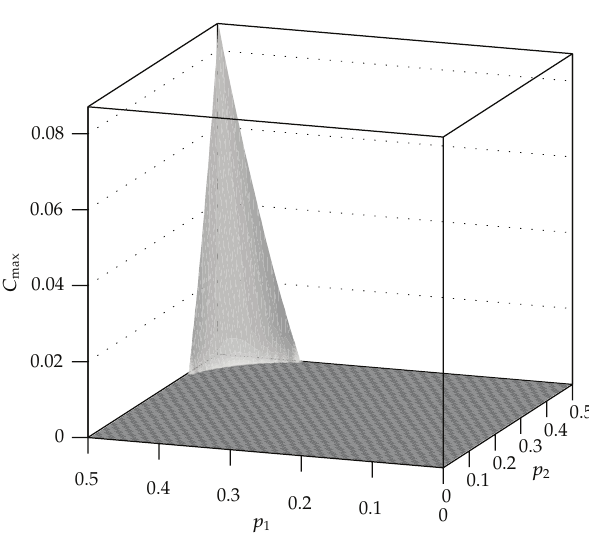
Figure 4: Maximal concurrence as a function of the independent parameters, p 1 (cid:8) v 1 and p 2 (cid:8) v 2 . As one can see the maximal concurrence is realized at the external corner, that is p 1 (cid:8) p 2 (cid:8) 1 / 2. Here is (cid:9) (cid:8) 1, N (cid:8) 40 and p (cid:8) 1 / 2 for all other